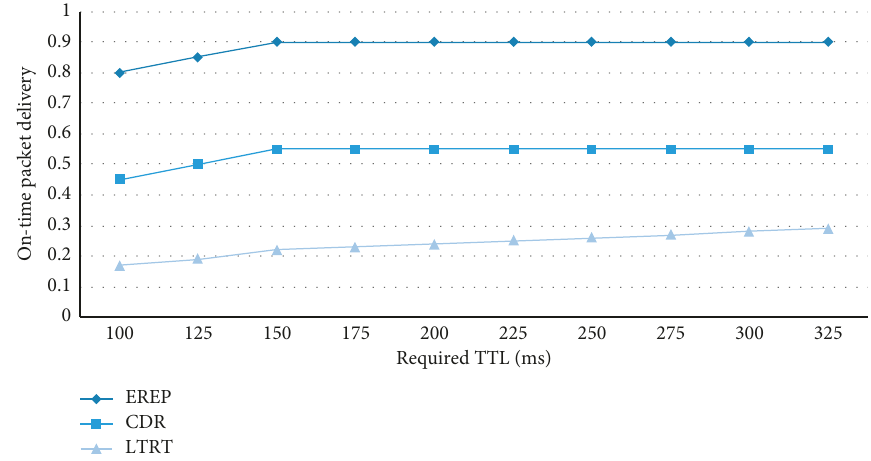
Figure 6: On-time packet delivery ratio vs. required TTL considering different data